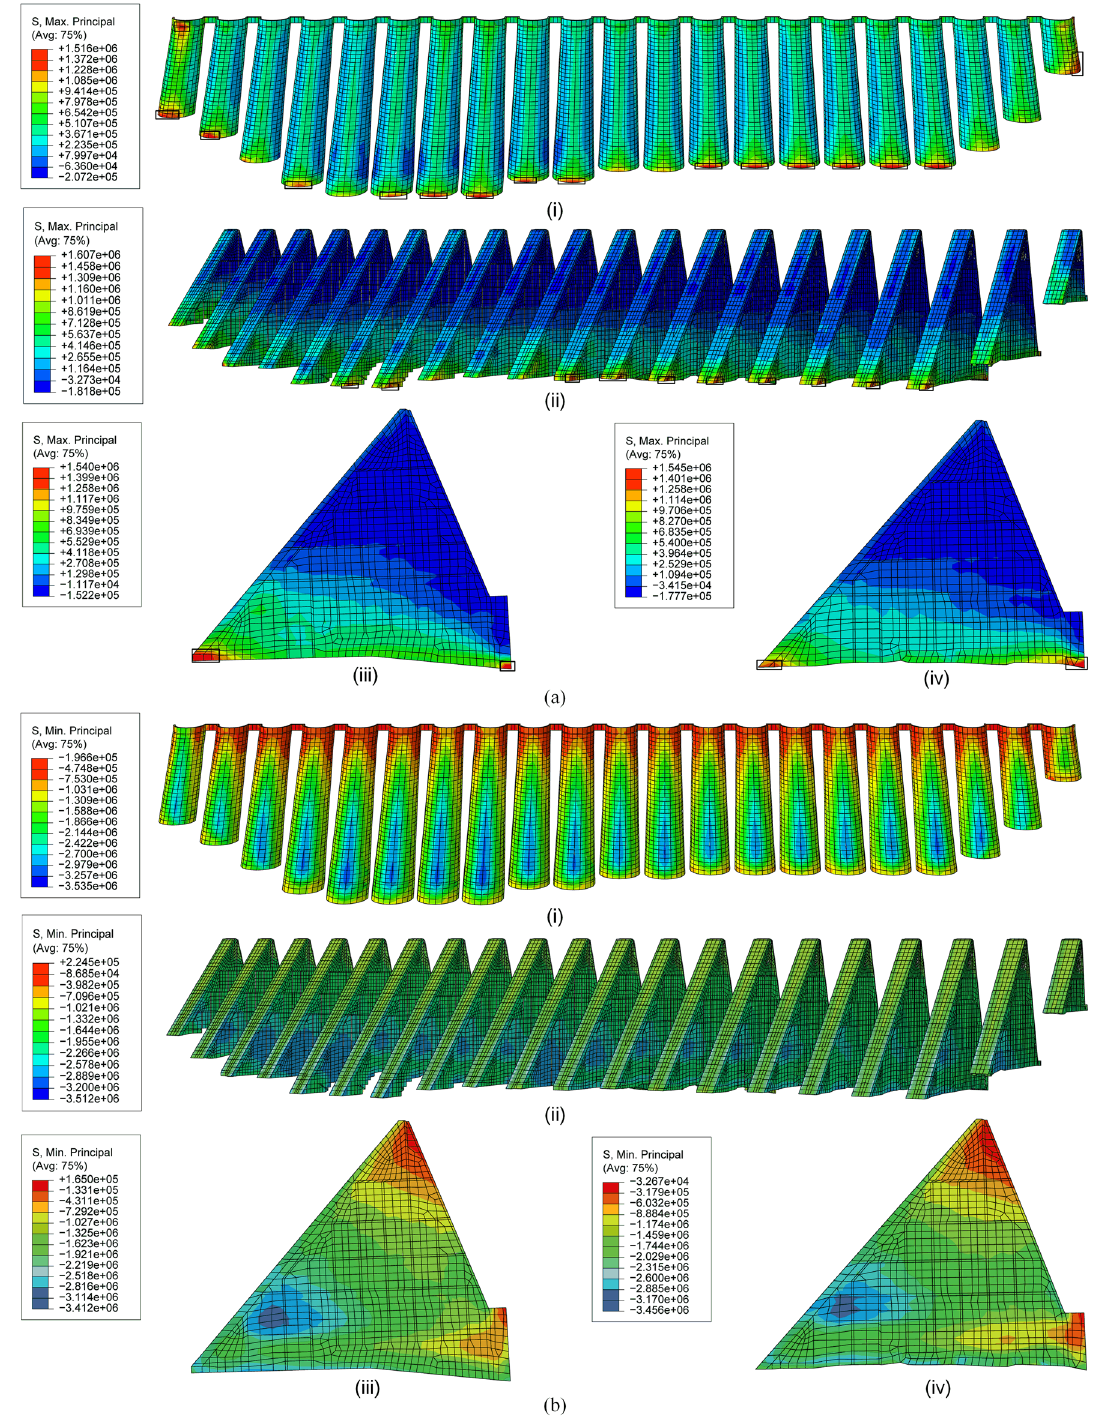
Figure 20. Principal stresses under loading C1: ( a ) maximum and ( b ) minimum principal stresses on (i) arches, (ii) buttresses, (iii) No. 12 buttress and (iv) No. 13 buttress (unit: